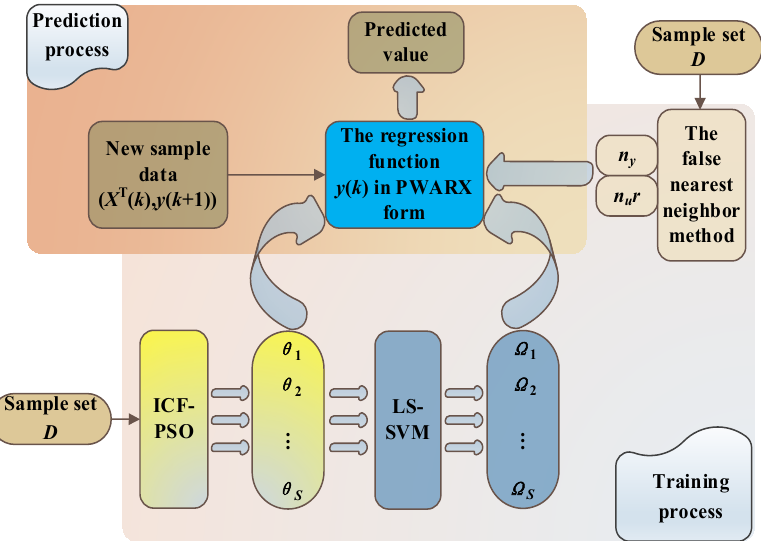
Figure 1. Overall structure diagram of modeling algorithm.